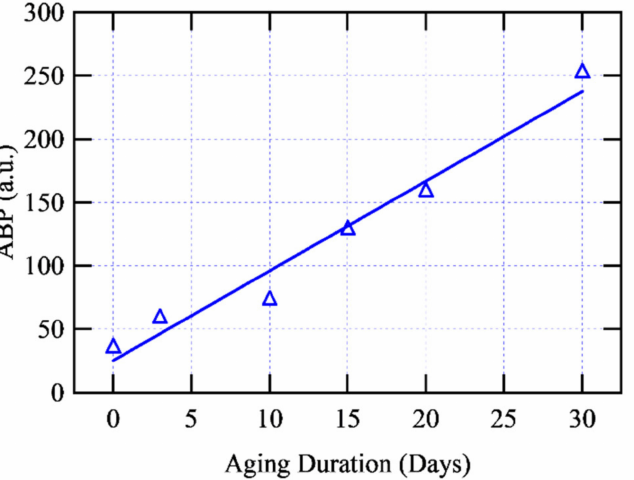
Figure 8. The increment in ABP of different transformer oil samples with different aging durations.